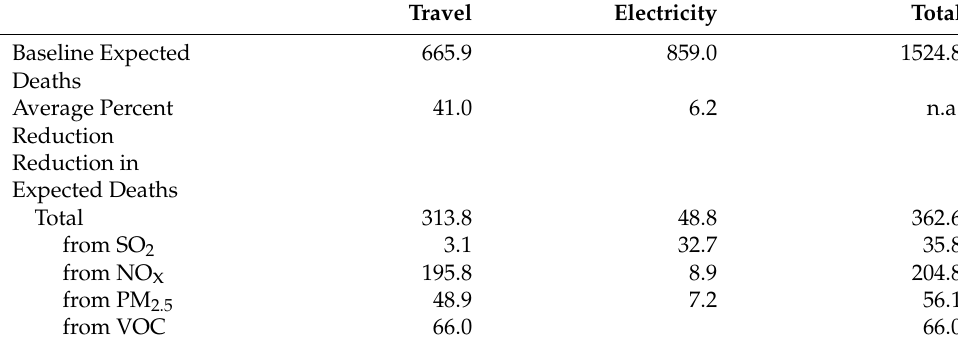
Table 3. Monthly reduction in deaths from reduced air